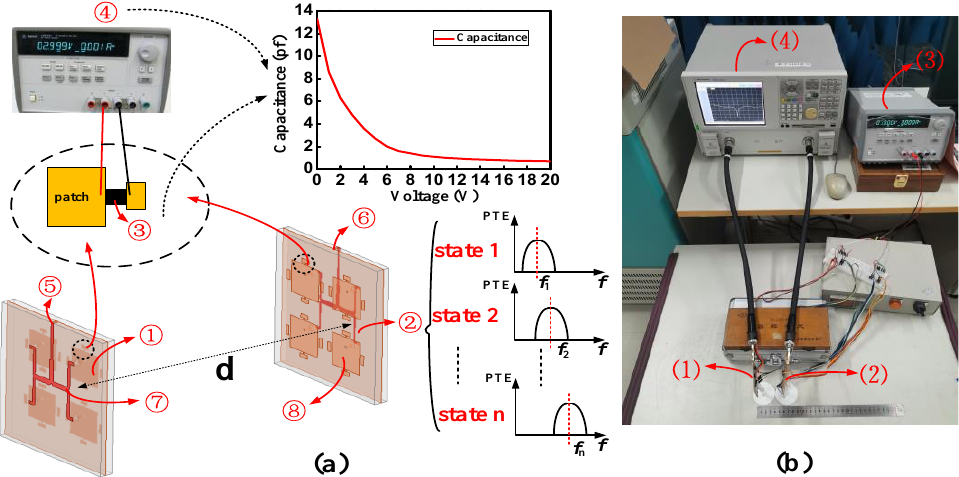
Figure 9 . ( a ). The model of the microwave wireless power transfer (MWPT) system ( ① : transmitter, Figure 9. ( a ). The model of the microwave wireless power transfer (MWPT) system ( 1 (cid:13) : transmitter, 2 (cid:13) : receiver, 3 (cid:13) : varactor ② : receiver, ③ : varactor diode, ④ : DC voltage source, ⑤ : lumped port 1, ⑥ : lumped port 2, ⑦ : diode, 4 (cid:13) : DC voltage source, 5 (cid:13) : lumped port 1, 6 (cid:13) : lumped port 2, 7 (cid:13) : feed network, 8 (cid:13) : patch). ( b ). The experimental feed network, ⑧ : patch). ( b ). The experimental platform for the MWPT system ((1): transmitter, (2): platform for the MWPT system ((1): transmitter, (2): receiver, (3): DC voltage source, (4): vector network receiver, (3): DC voltage source, (4): vector network analyzer).